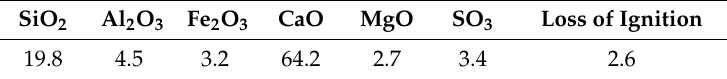
Table 1. Mass percentage of oxides determined by XRF for the cement.